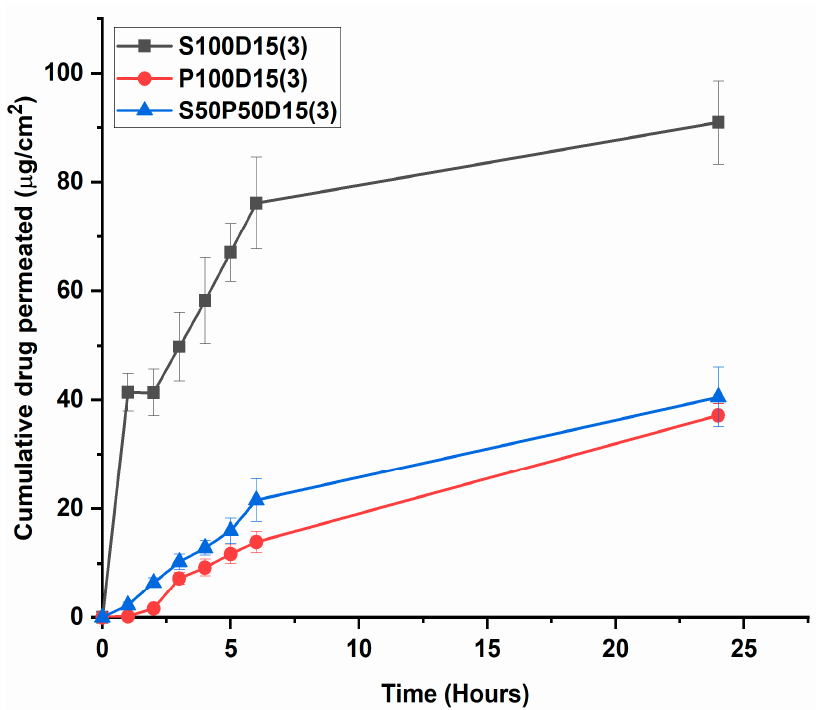
Figure 7. Cumulative drug permeated from drug loaded SA/PVA-MMT clay-reinforced nanocom- posite films at pH 6.8 in 1× PBS.